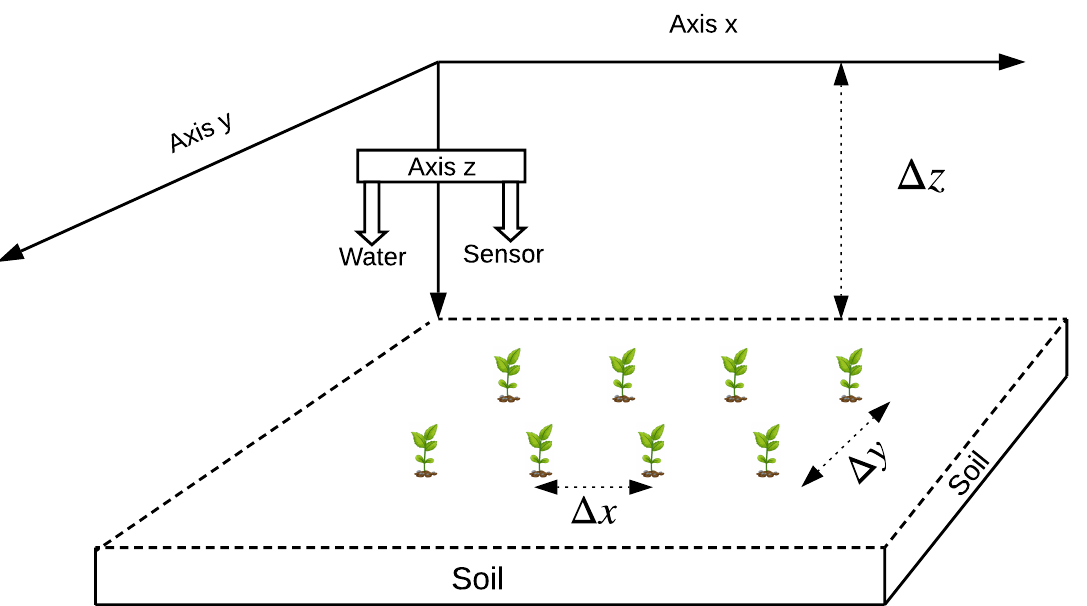
Figure 4: Movements of the prototype in the